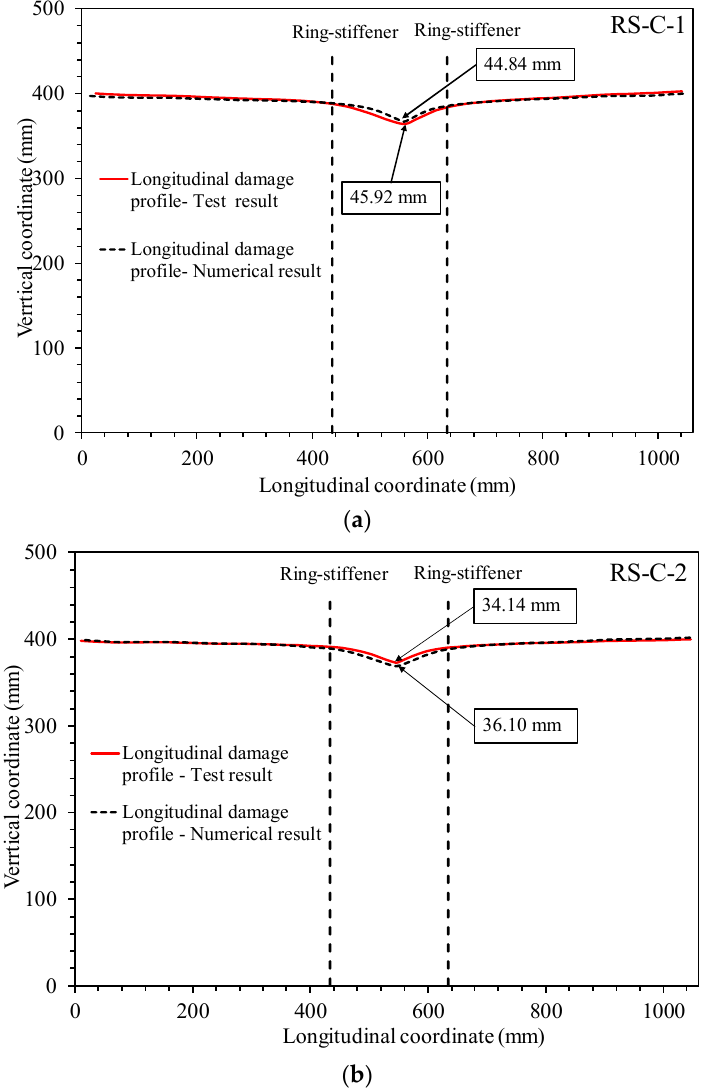
Figure 5. Comparison of the longitudinal damage profiles obtained from experimental and numerical prediction: ( a ) model RS-C-1; ( b ) model RS-C-2.